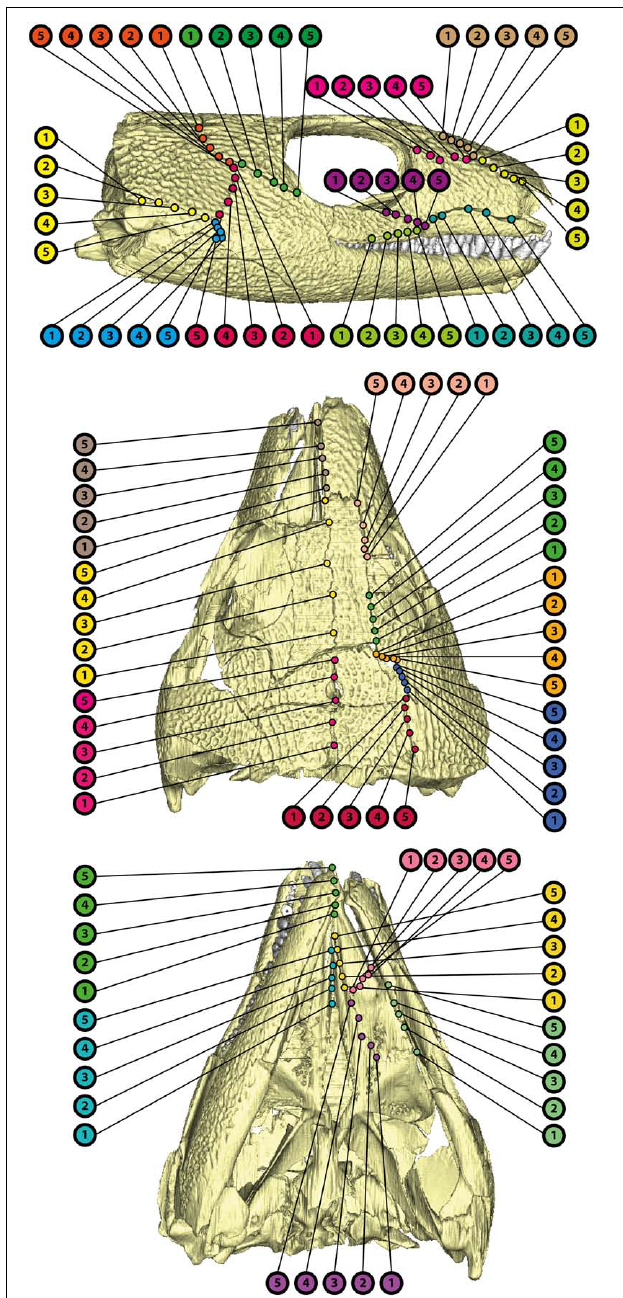
FIGURE 11 | Points of measurements for suture thickness in OMNH 44816 as indicated in Supplementary Table 2 .